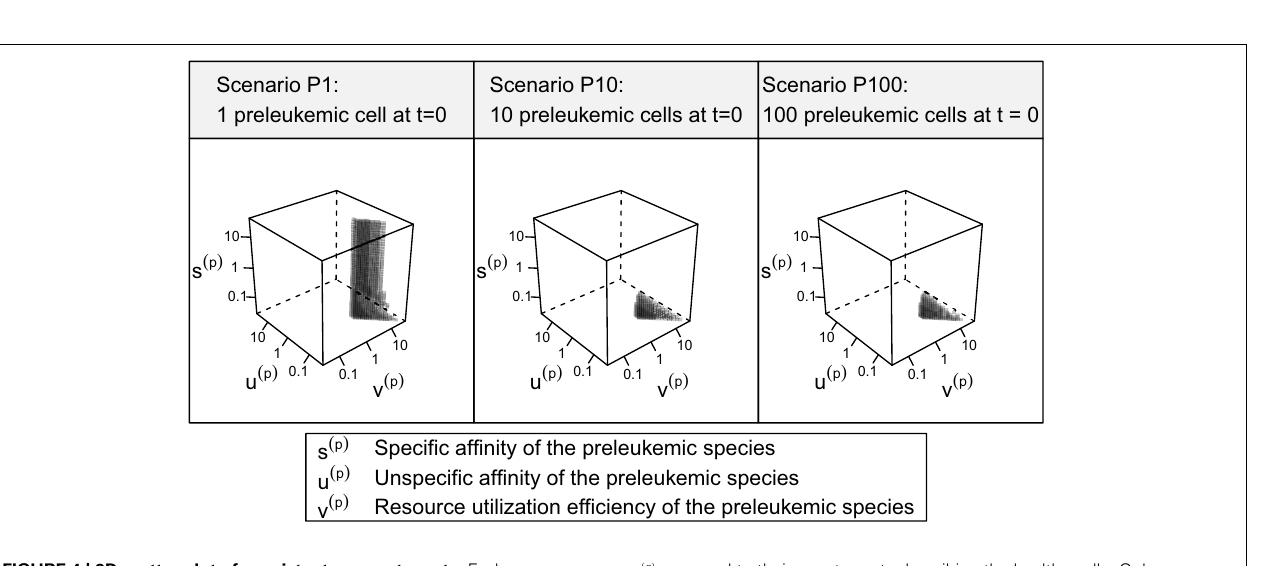
v ( p ) are equal to their counterparts describing the healthy cells. Only the parameter sets that are consistent with the experimental observations (criteria in Table 1 ) are plotted.Transparency is used in order to give an impression of the shape of the consistent parameter